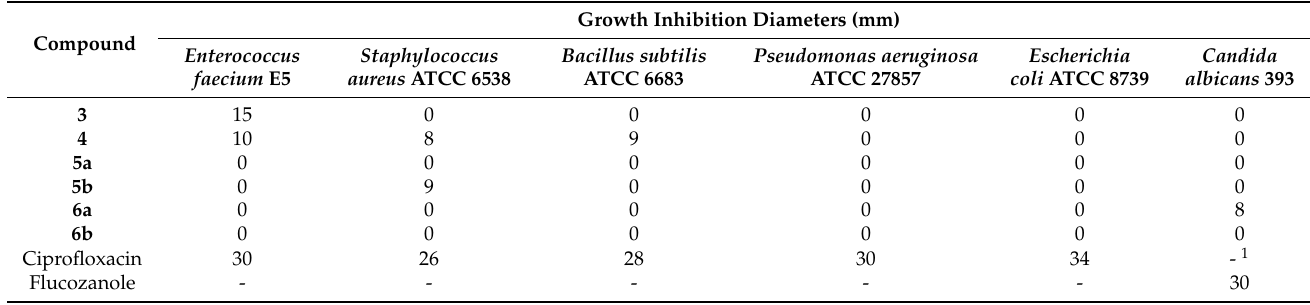
Table 1. Results of the qualitative assay of the antimicrobial activity of the tested compounds by using an adapted diffusion assay (the growth inhibition diameters were measured and expressed in